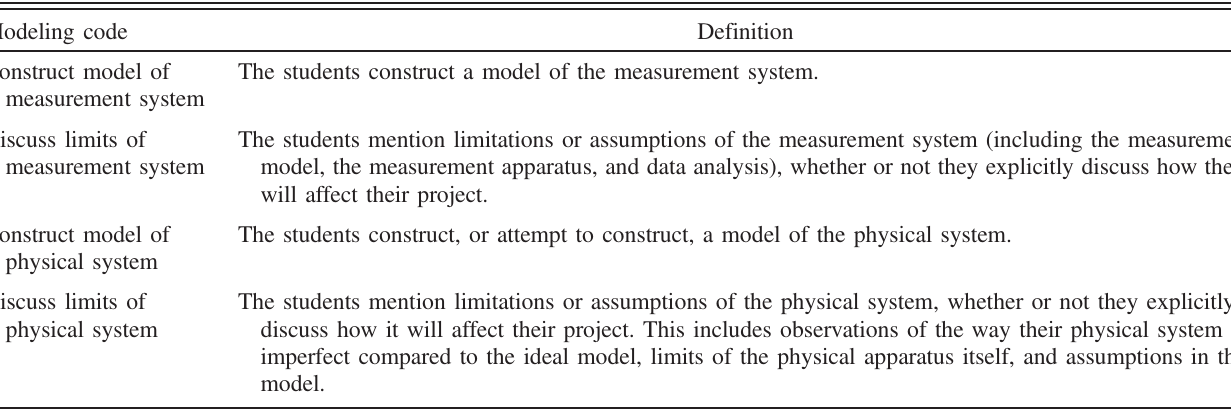
TABLE VII. Emergent subcodes of engage with models codes and their definitions. The first two codes in this table are subcodes of engage with model of measurement system and the last four are subcodes of engage with model of physical system